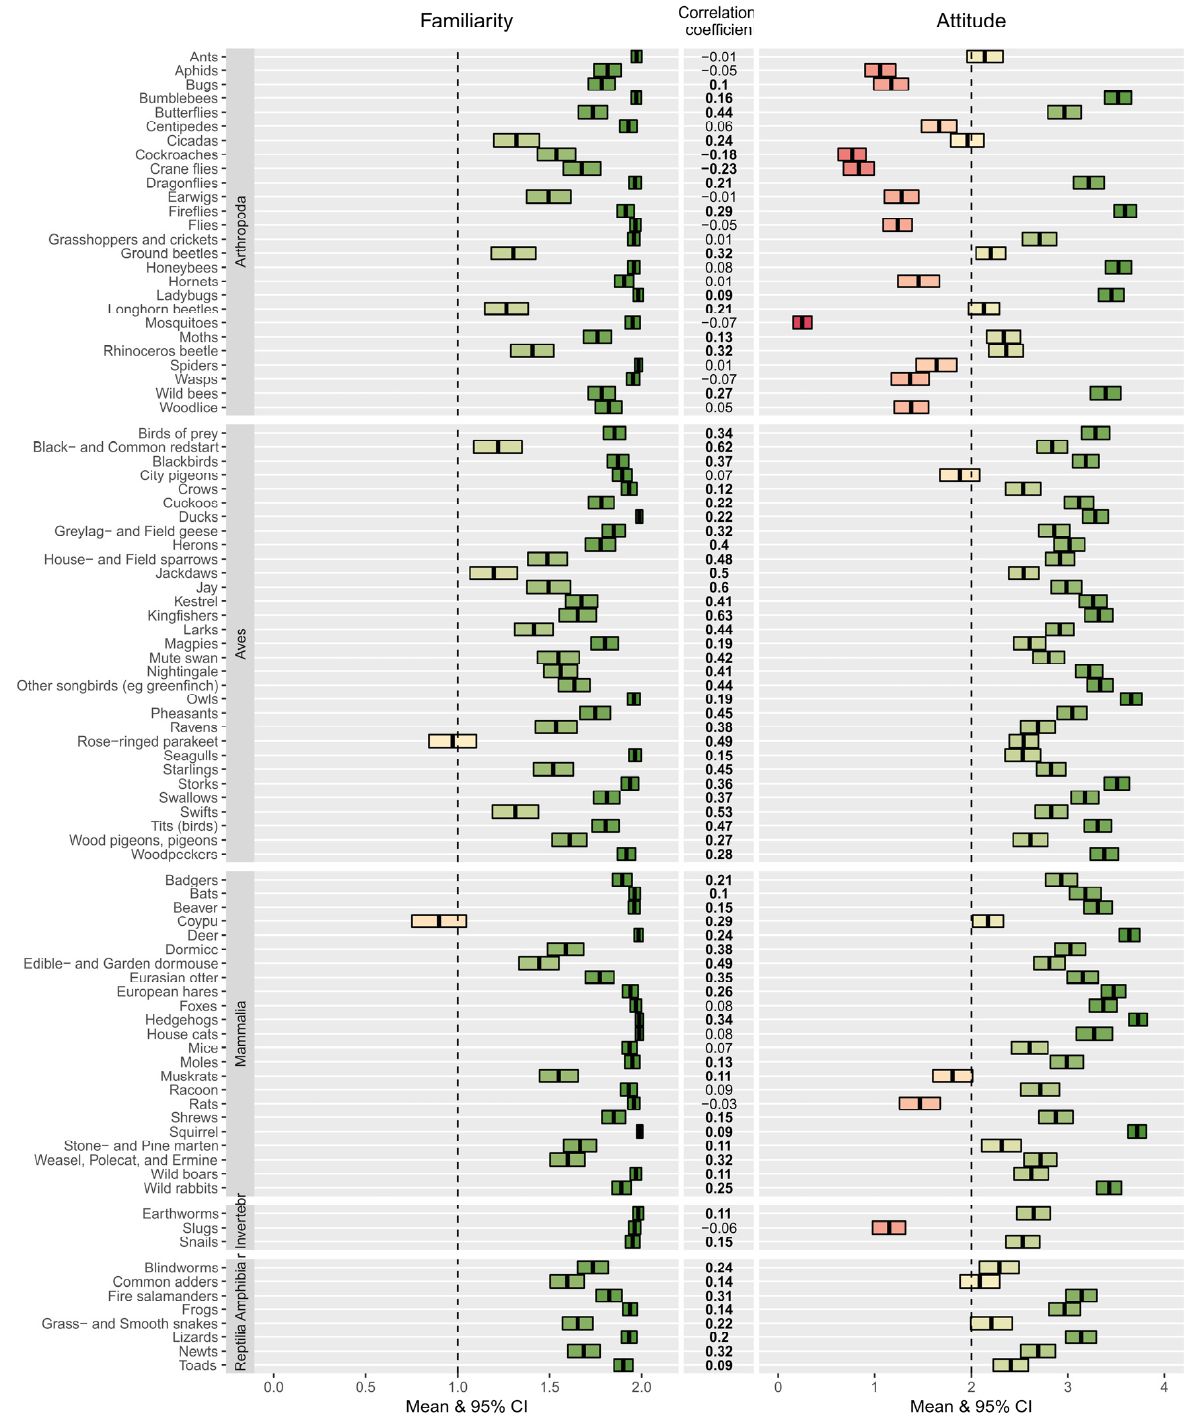
Figure 1. Mean familiarity and attitude towards individual animal species and the correlation coefficient between them. Boxes indicate mean ± 95% CI. Bold correlation coefficient values indicate a significant correlation; cursive values indicate no significant correlation. See Appendix C for a tabular representation of the data.